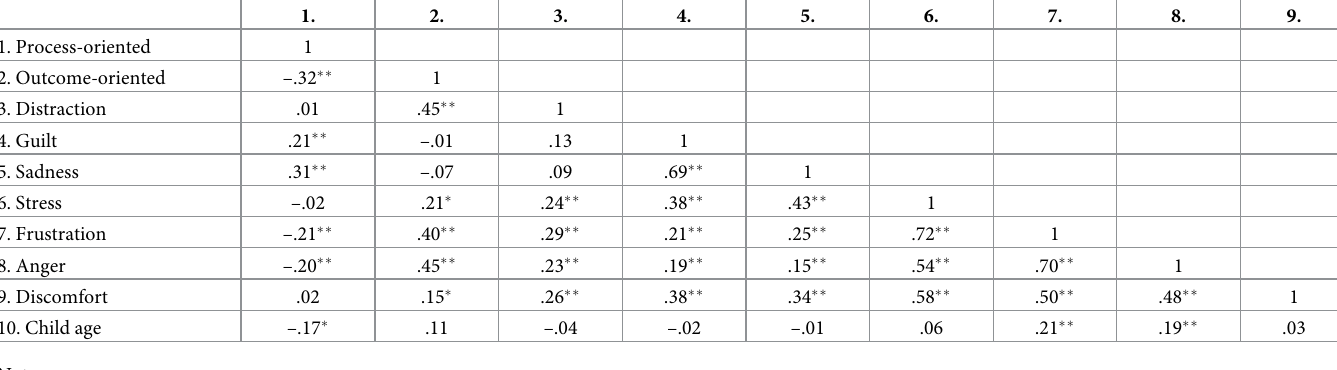
Table 3. Correlations among variables of interest for children’s perceived unjustified negative